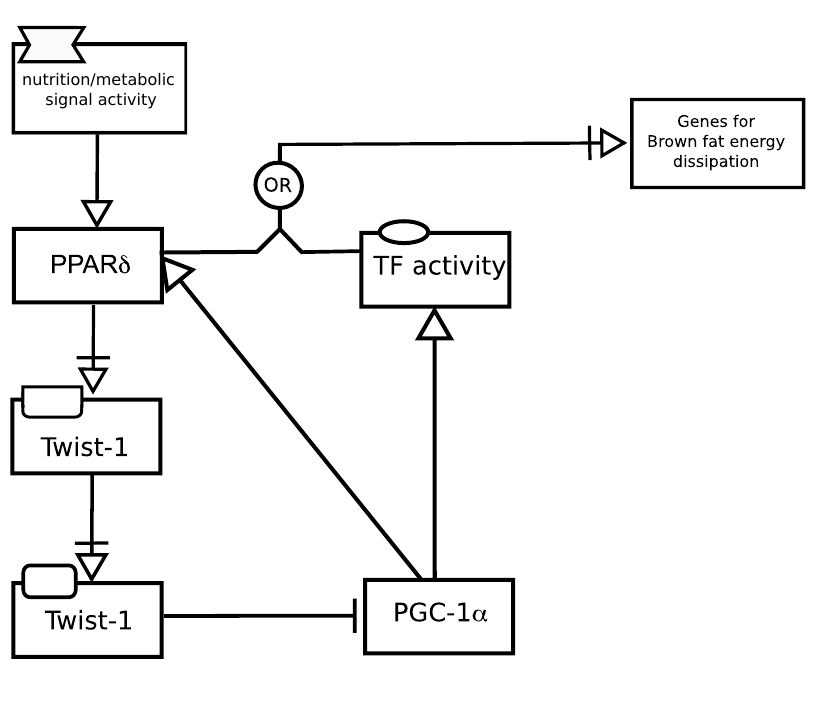
Figure 2.1: This example of Activity Flow is based on Figure 7E of Pan el. al. [2]. It depicts the effect of nutrients and metabolic signals on brown fat metabolism through PPAR δ . The signal, shown as a perturbation, positively influences the nuclear hormone receptor PPAR δ , which in turn stimulates the Twist 1 gene expression. Please note the different units of infor- mation on Twist-1 activity nodes that indicate the activity from different biological materials (gene and protein). The Twist-1 protein negatively influences the PGC-1 α activity, which positively influences PPAR δ and other unspecified transcription factor activity to stimulate the expression of genes for brown fat energy dissipation. Therefore, the Twist-1, induced by PPAR δ , serves as a negative feedback regulator of PGC-1 α in brown fat